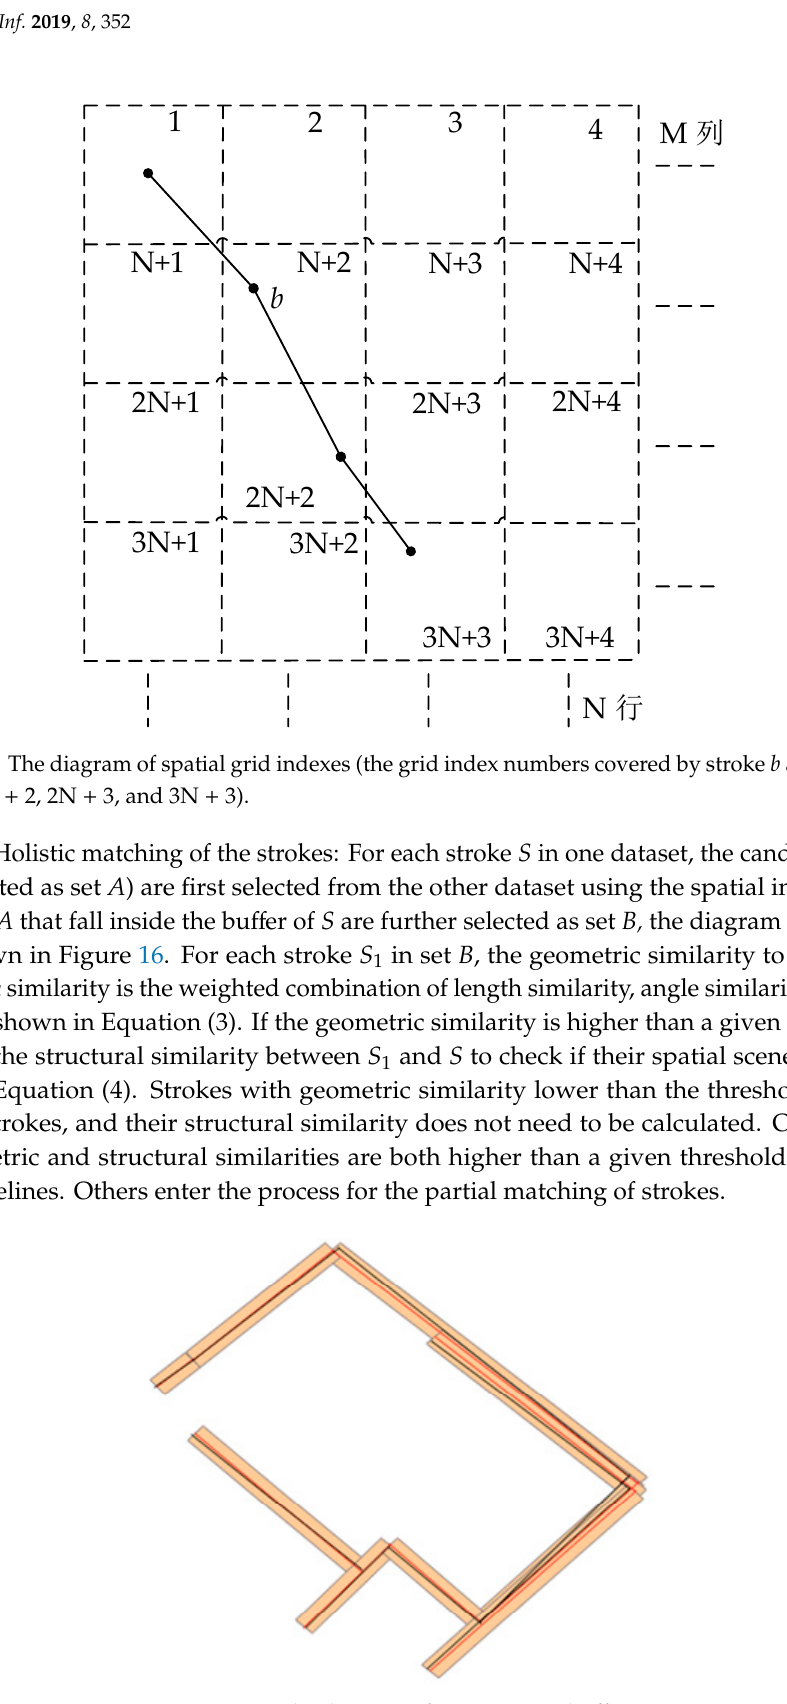
Figure 16. The diagram of approximate buffer.